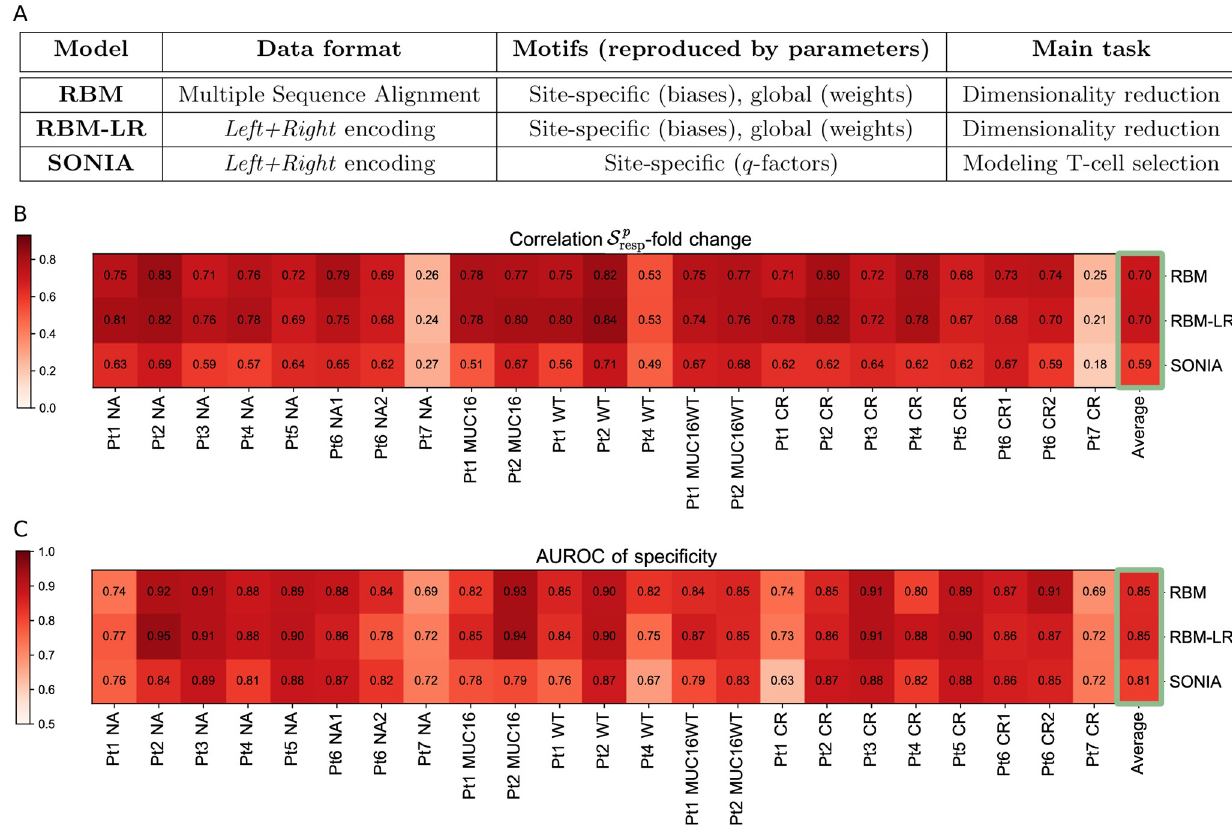
Fig 8. Comparison of the methods. A: Schematic summary of the characteristics of the three sequence-based probabilistic modeling approaches used: RBM, RBM-LR, SONIA. B-C: Summary of the results we obtained for the samples from [16] using the approaches in A, in particular the correlation between the model’s response score S p and TRB clone fold change when retaining the 125 most abundant clones (B) and the AUROC-based measure of resp response specificity (C). Both these measures highlight a different degree of specific response to the stimulation, that overall stays high across the samples apart from Pt7, where response to the peptides tested was rather unspecific. For each sample, the results from the three methods are well in agreement (see -fold change correlation reflect also how well the probability inferred by each method also Figs 3C and 4E). High values of the AUROC and of the S p resp reproduces the clone abundance (see S3 Fig, Materials and methods), thus we report the averages over all samples (last column) for a comparison of the methods’ performance. This comparison shows that the general performance is higher for RBM-based approaches than for SONIA and is the same for RBM and